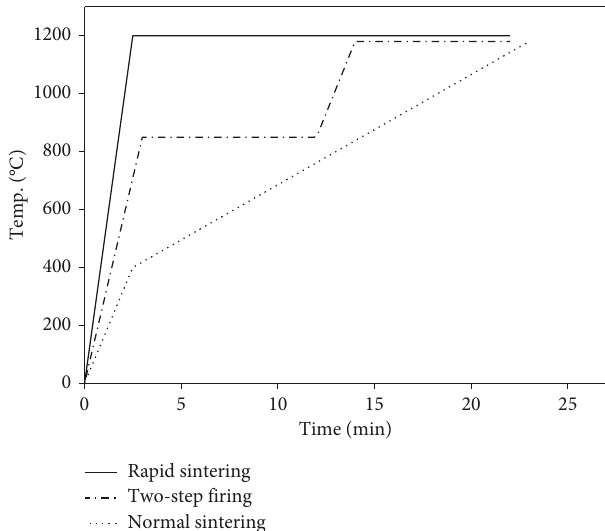
Figure 1: Schedule of heating by different ramping rates.